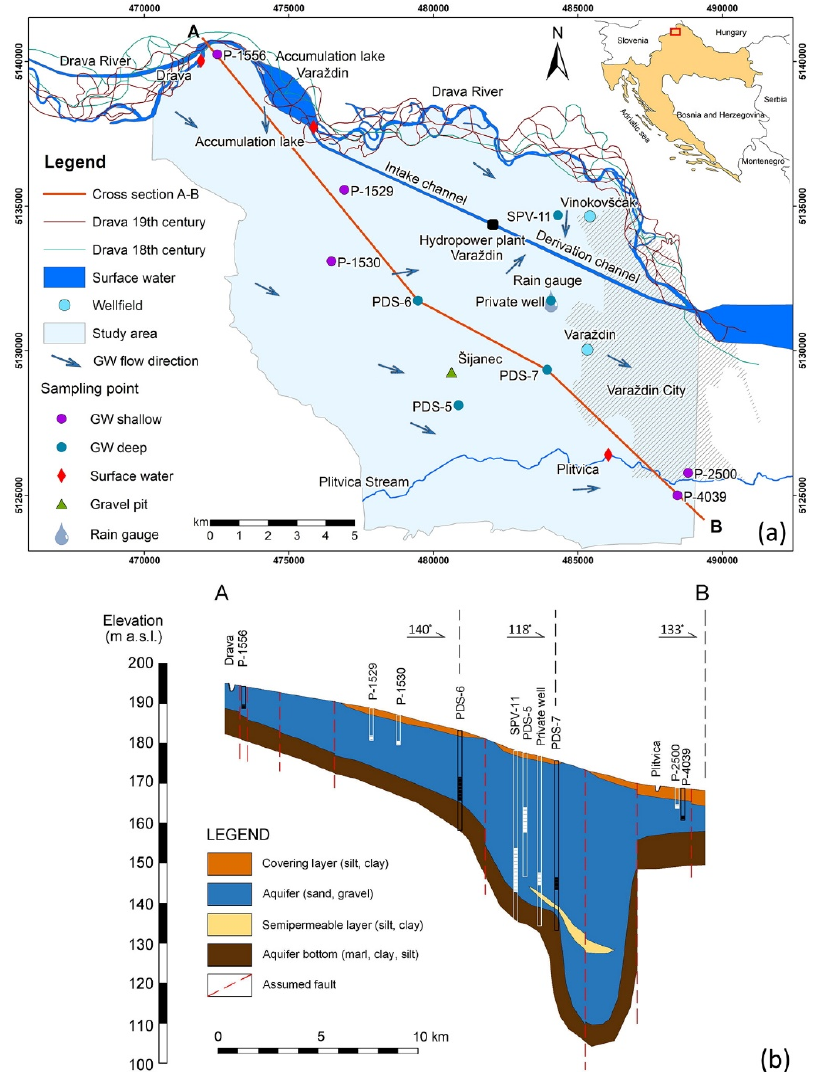
Figure 1. Map showing the geographical location of the study area with sampling sites ( a ), and the representative hydrogeological cross-section A–B ( b ). Observation wells (black) are located precisely on the cross-section, while the positions of the observation wells (white) are only approximated. The general groundwater flow direction is presented for average groundwater levels [32] .